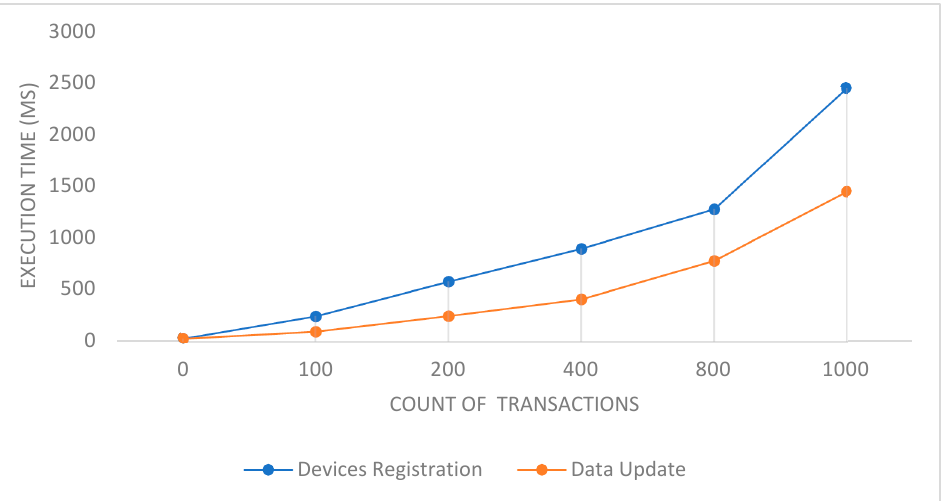
Figure 14. Execution time of main processes in the proposed framework.